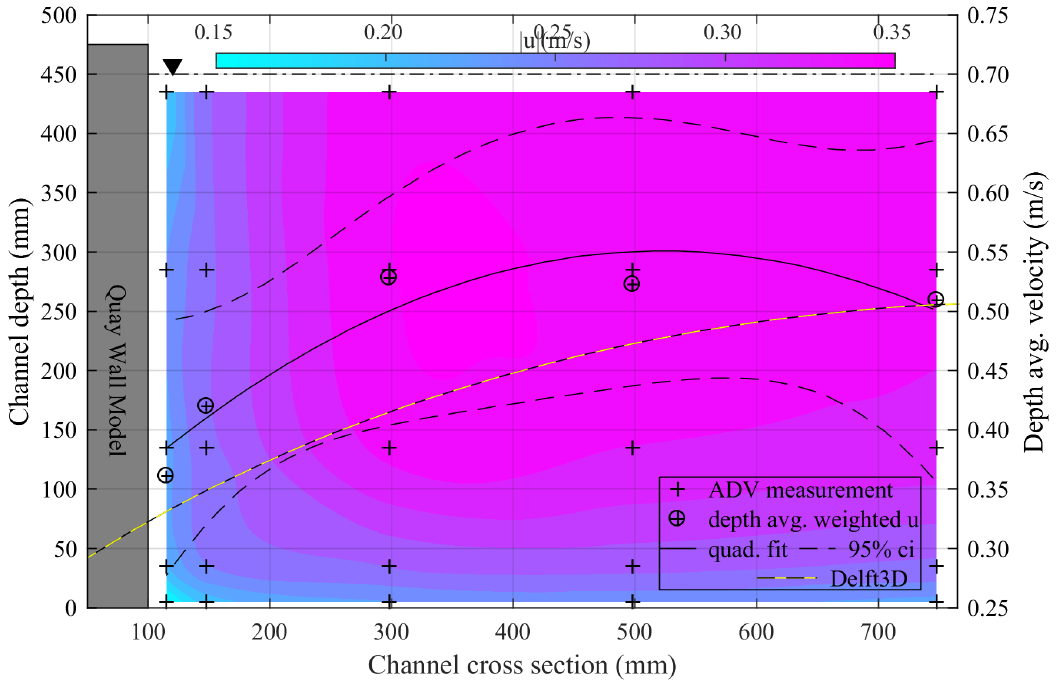
Figure 6. Velocity profile measured on the physical flume model (PFM) in cross channel direction at the end of the structure complimented by depth averaged values and a corresponding quadratic fit and numeric results.